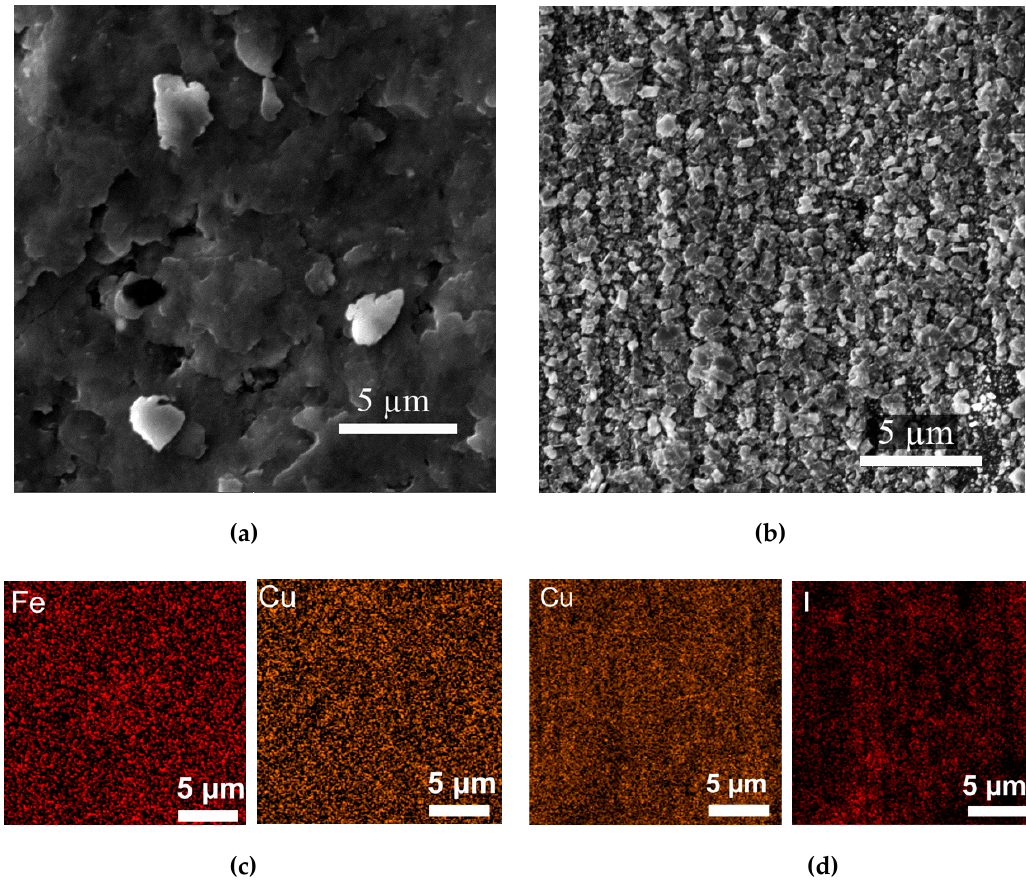
Figure 4. ( a ) FeCu deposition on the copper substrate, ( b ) CuI growth on Cu, ( c ) EDS mapping of the FeCu distribution and ( d ) EDS mapping of the CuI distribution.